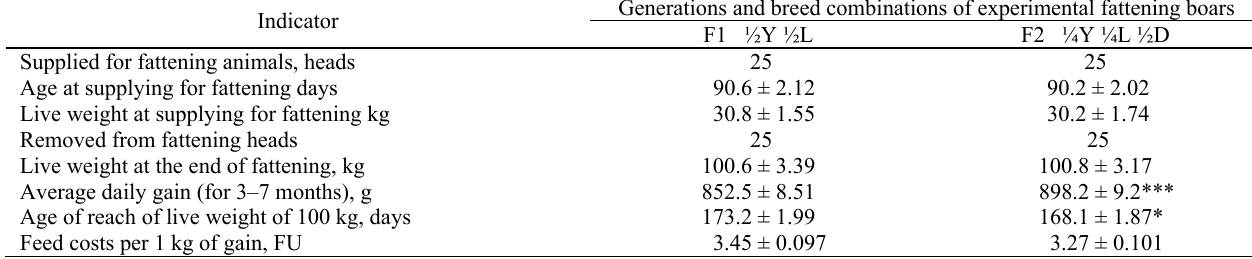
Generations and breed combinations of experimental fattening boars